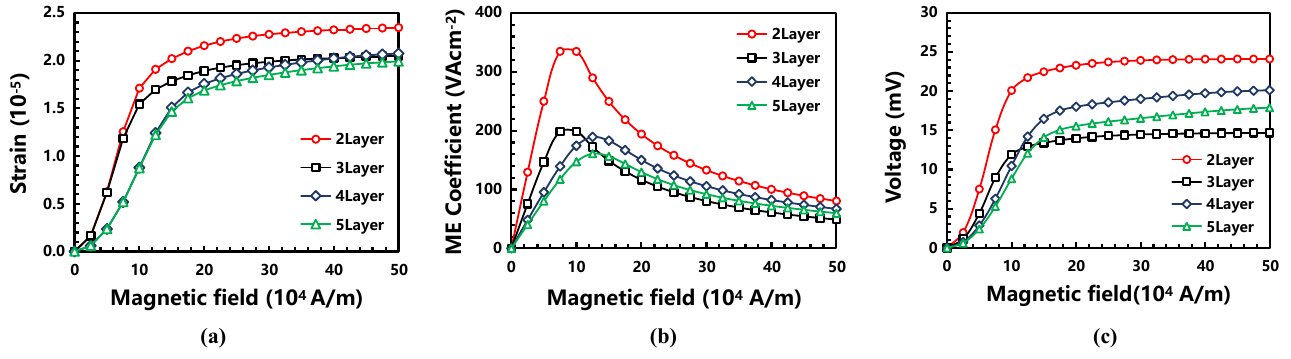
Figure 5. With the increase in the bias DC magnetic field: ( a ) the variation curve of the strain, ( b ) the variation curve of the ME coefficient, and ( c ) the output voltage of the ME heterostructures in different layers.